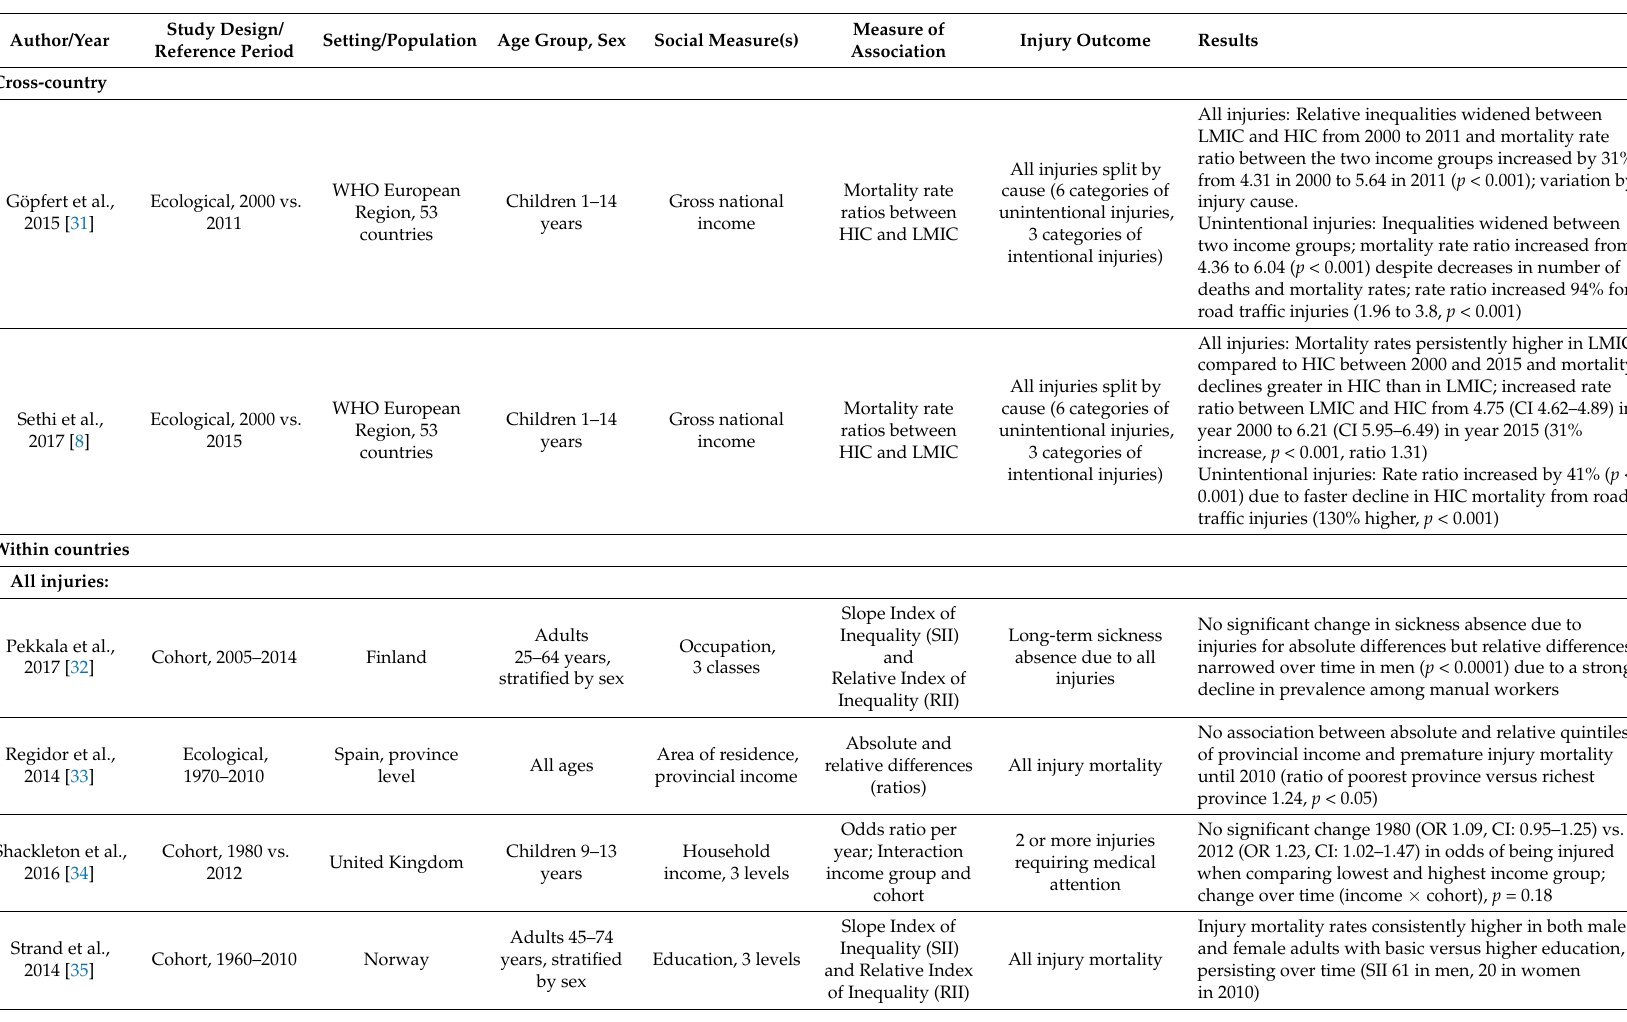
Table 2. Descriptive characteristics of studies on injury inequalities investigating changes over time, cross-country and